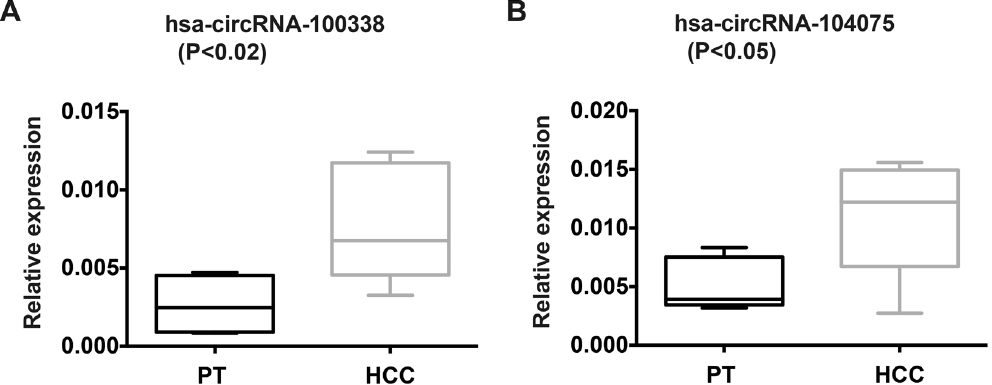
Figure 2. qRT-PCR verification of the expression of two circRNAs ( A ) circRNA_100338 and ( B ) circRNA_104075 in HCC and paired pericancerous tissues (PT) samples (additional six patient samples; n =